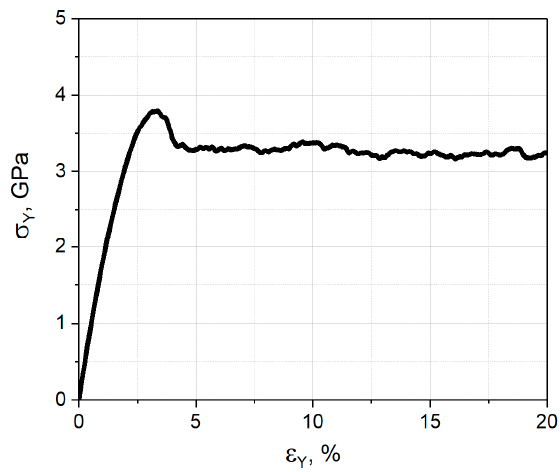
Figure 2. Stress–strain dependence for the bcc30_L1 sample in tension.